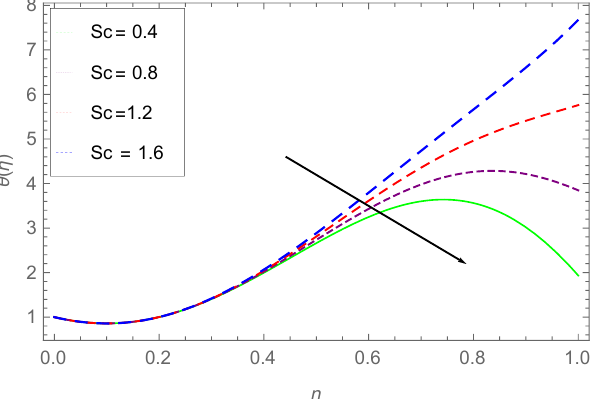
Figure 10. Impact of Sc on θ ( η ) , when Nb = 0.5, (cid:101) = 0.1, β = 0.1, S = 0.3, Nt = 0.3, Pr = 0.6.